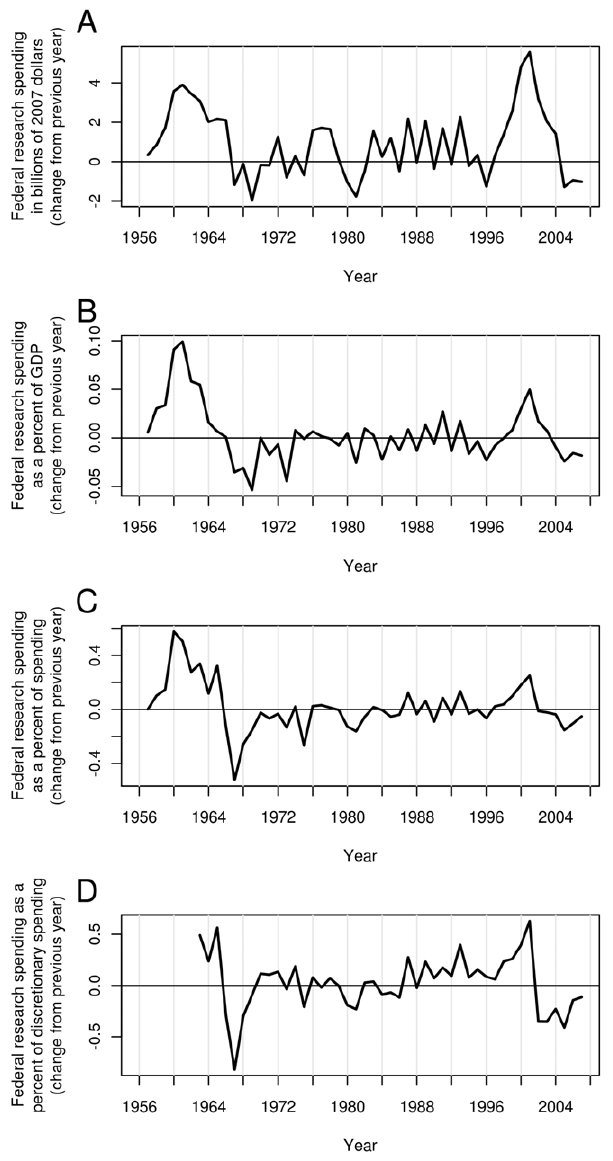
Figure 3. Change in FRF in the US during the last six decades. Each point on the graph represents the difference in FRF between consecutive years. The change in FRF can be viewed in inflation adjusted dollars (A), as a percent of GDP (B), as a percent of federal spending (C), and as a percent of federal discretionary spending (D).